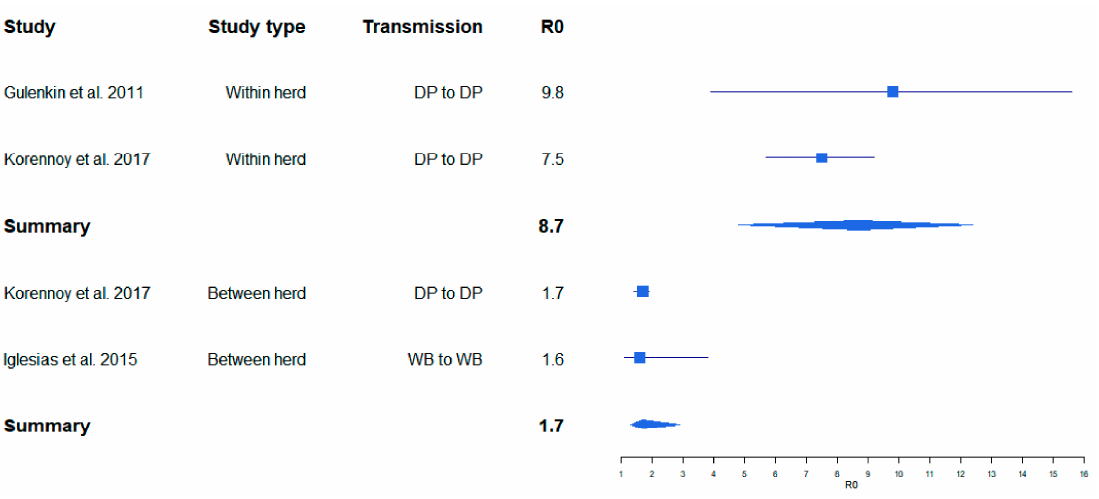
Figure 1. Variation of calculated R 0 for African swine fever (ASF) obtained from ASF field studies. Boxes illustrate the calculated R 0 . The lines illustrate the confidence intervals. DP = domestic pig, WB = wild boar.